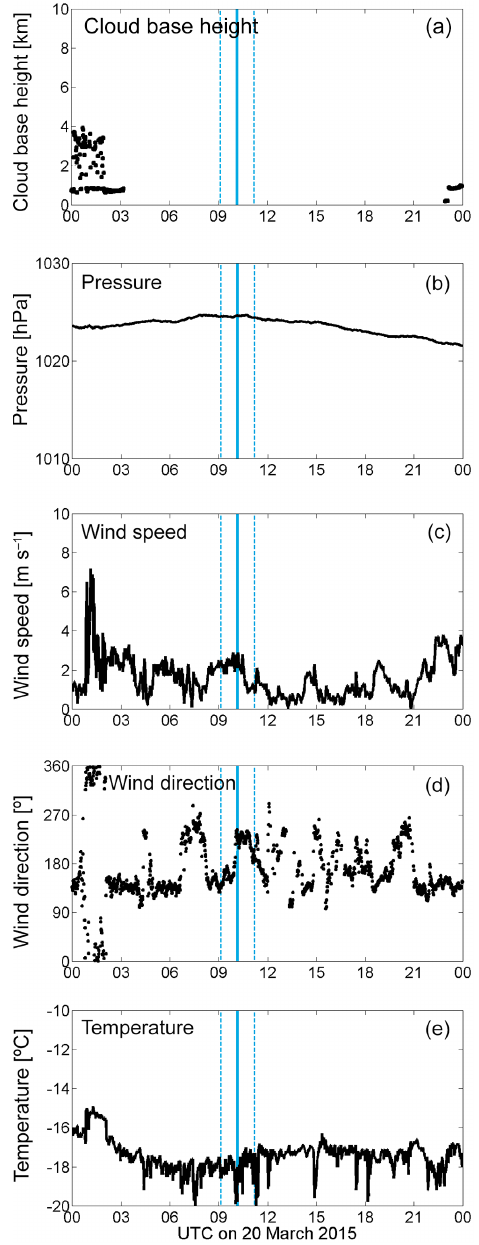
Figure 2. Meteorological surface observations in Ny-Ålesund on 20 March 2015, with (a) cloud base height, (b) station level pres- sure, (c) 10m wind speed, (d) 10m wind direction, and (e) surface air temperature at 2m height. Indicated is the duration of the solar eclipse (dashed blue lines) and the time of total eclipse (blue